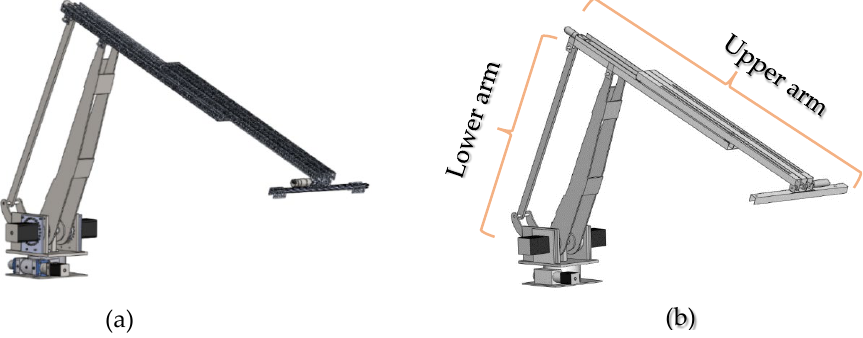
Figure 1. 5-DOF robotic manipulator used here: ( a ) its DOF; ( b ) its angles and lengths.